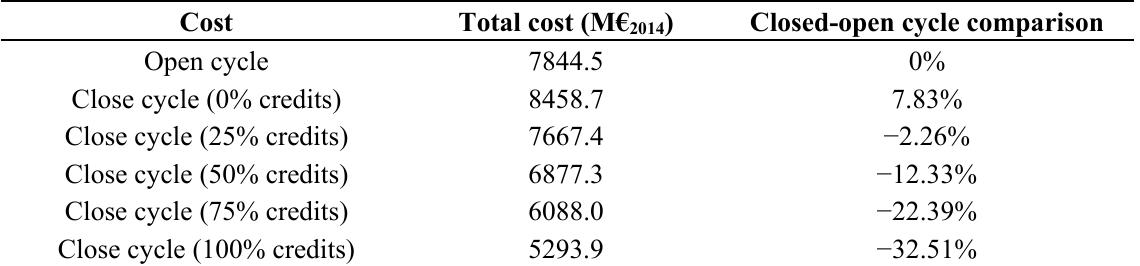
Table 8. Total Cost in terms of the cycle used and the credits obtained in the Closed